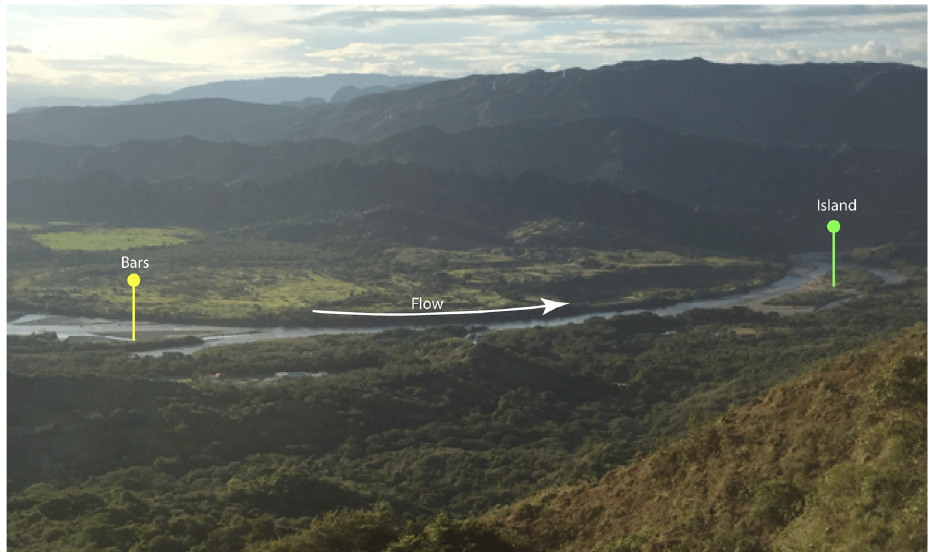
Figure 11. A Magdalena reach (120 km in Figure 8) flowing from left to right, located about 35 km upstream of the Betania dam, a few km downstream of Paez tributary. Mid channel, bank attached bars and even a large island (right) are visible. An influence from the downstream new El Quimbo Reservoir cannot be excluded; however, bars can also be found upstream.